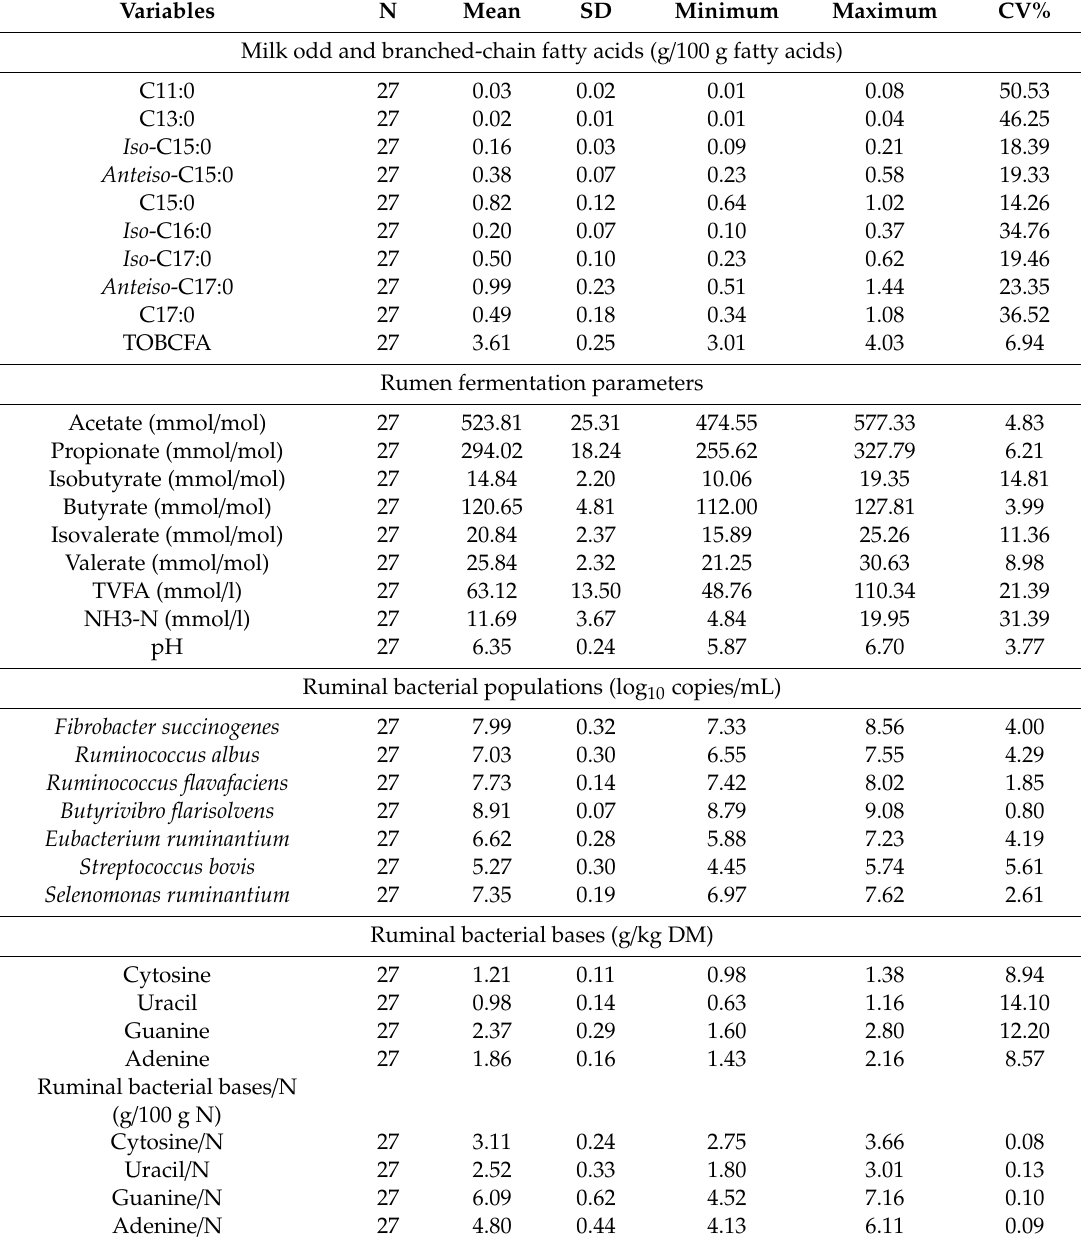
Table 5. Simple statistics of experimental data used for model